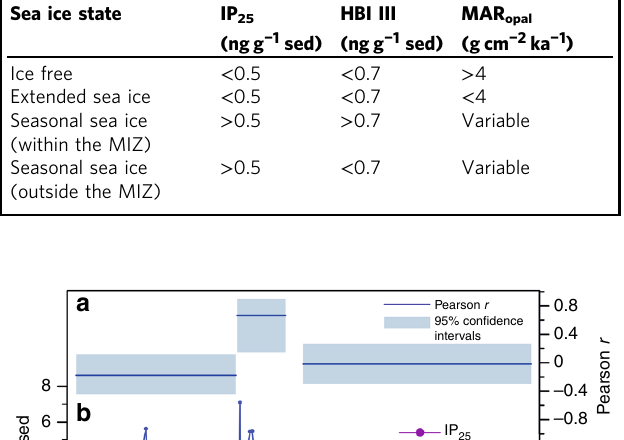
Table 2 Boundaries for identi fi cation of sea ice states Sea ice state